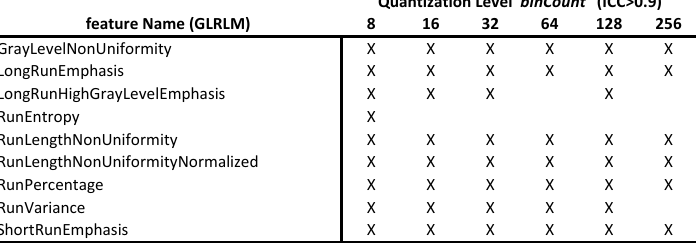
Figure 3. Dependence of the quantization level of GLRLM radiomic features, considering differ- ent values (i.e., 8, 16, 32, 64, 128, and 256) of the ‘binCount’ PyRadiomics parameter. The fea- tures SumSquares , GrayLevelNonUniformityNormalized , GrayLevelVariance , HighGrayLevelRunEmphasis , LongRunLowGrayLevelEmphasis , LowGrayLevelRunEmphasis , ShortRunHighGrayLevelEmphasis , and ShortRunLowGrayLevelEmphasis were discarded, as the ICC did not overcome the cutoff for any ‘binCount’ setting.